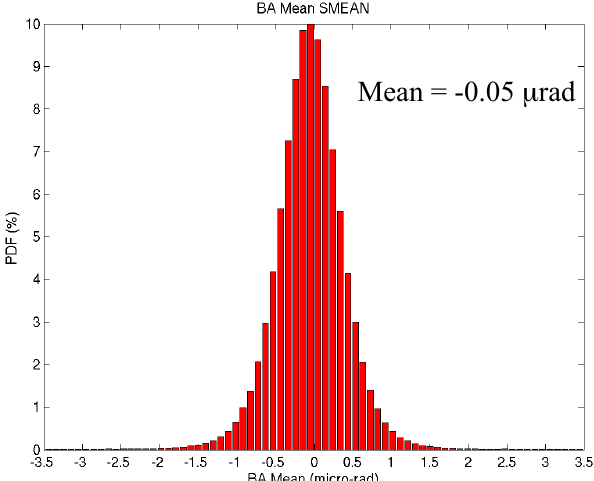
Fig. 18. Distribution of mean bending angle differences (from climatology) between 60 and 80km heights for ∼ 79000 Metop/GRAS profiles from July–December